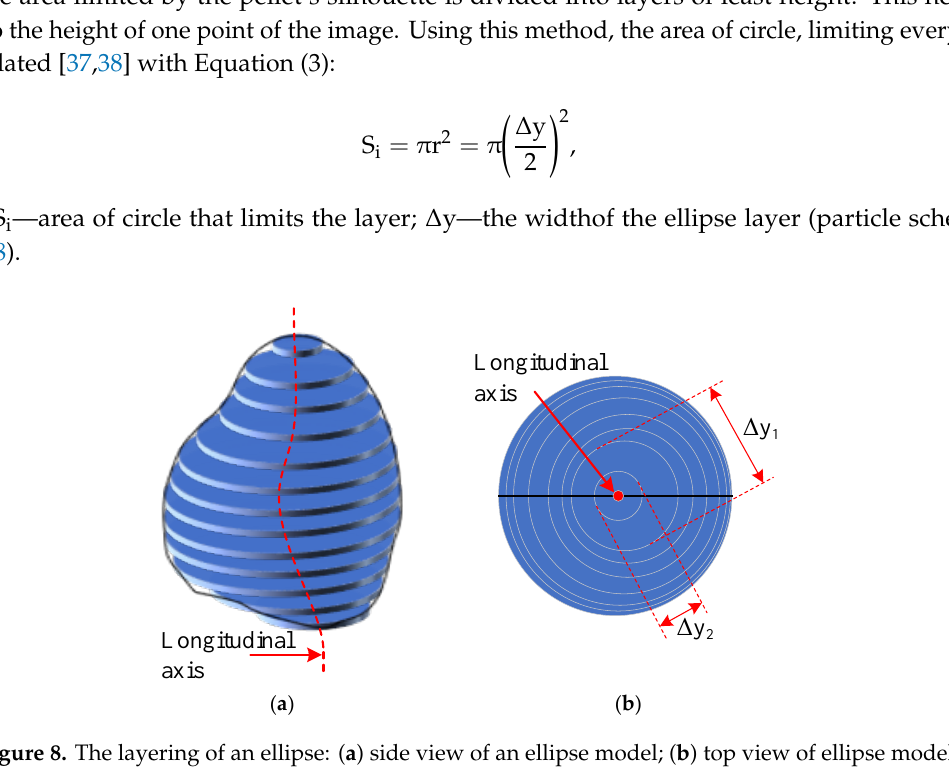
according to their size and roundness.